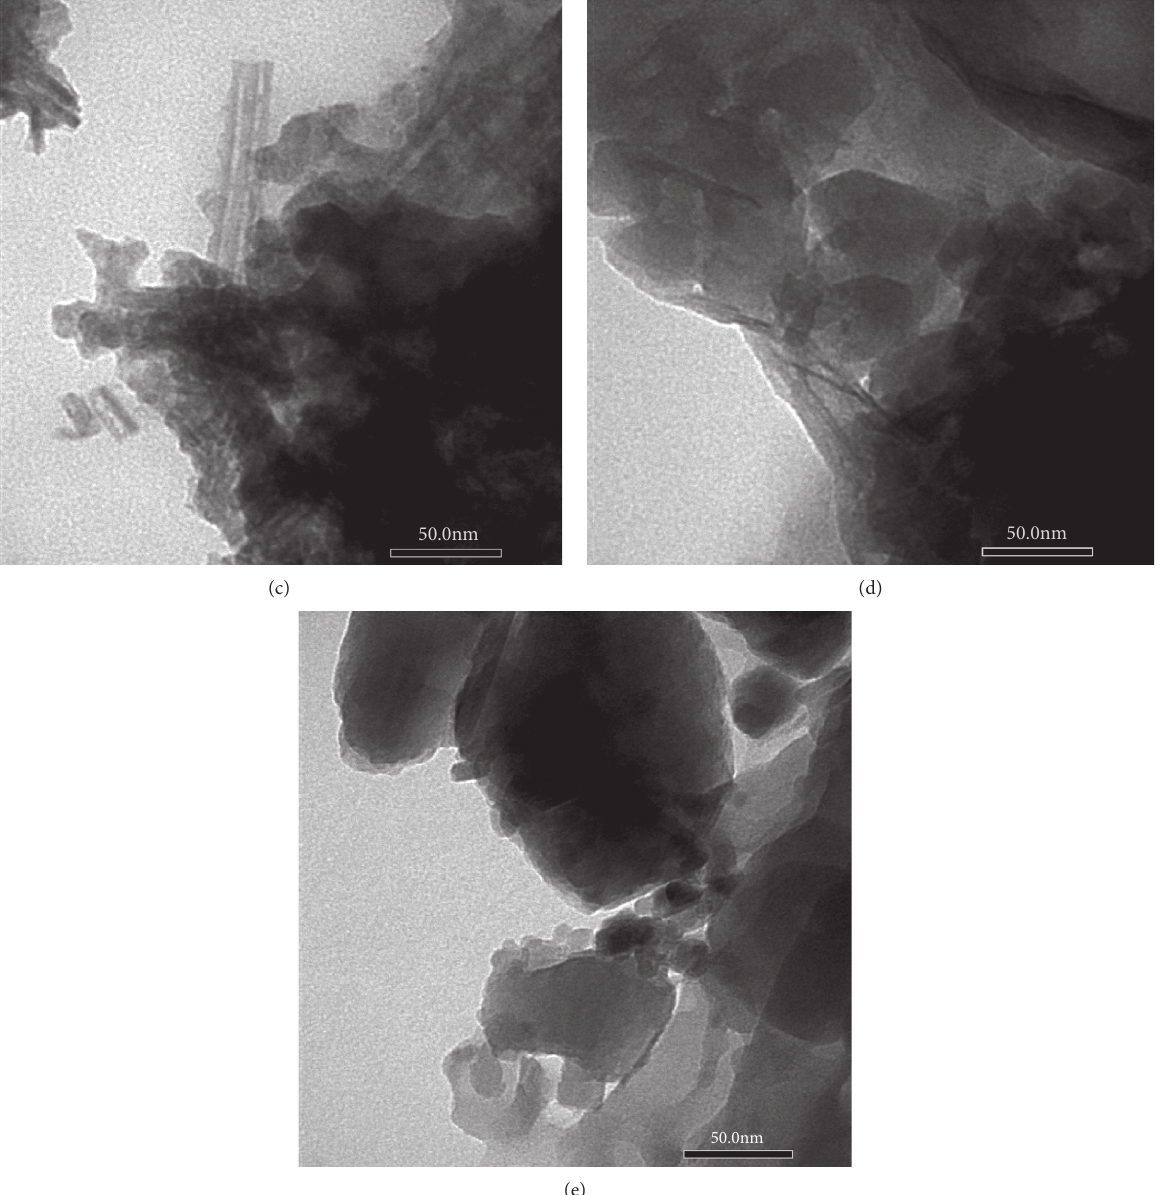
Figure 2: TEM images of (a) Ni nanoparticles; (b) particle diameter; (c) Ni-TiO